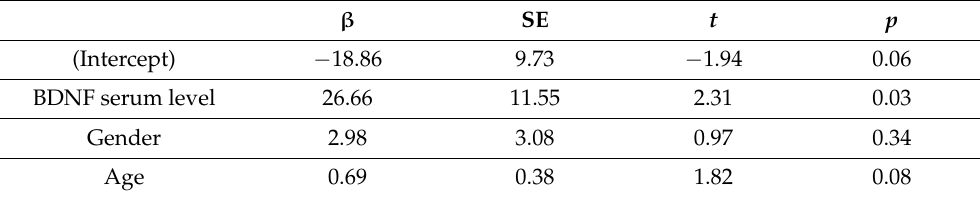
Table 3. A general linear model of serum BDNF and proteinuria. β SE t p (Intercept) − 18.86 9.73 − 1.94 0.06 BDNF serum level 26.66 11.55 2.31 0.03 Gender